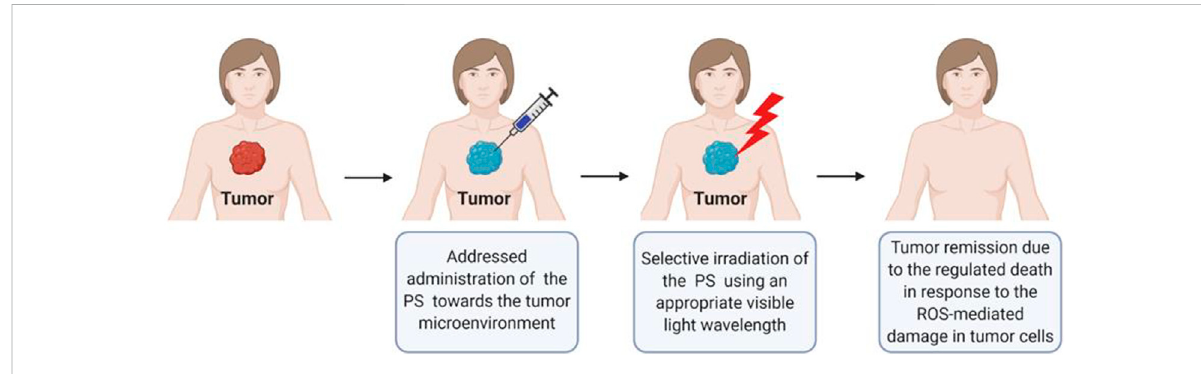
FIGURE 1 Simpli fi ed procedure of photodynamic therapy in patients. Created with BioRenders by